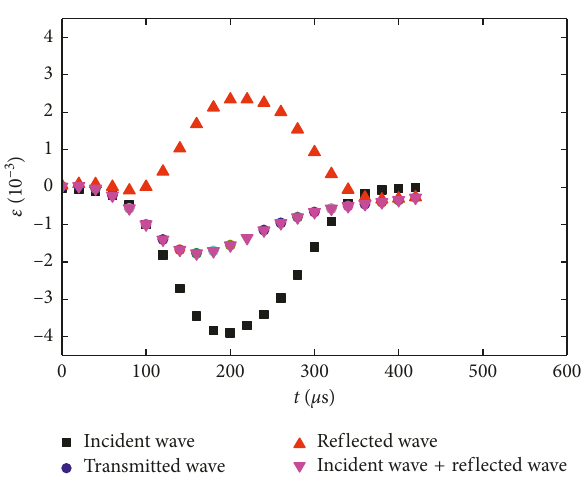
Figure 4: SHPB test waveform of